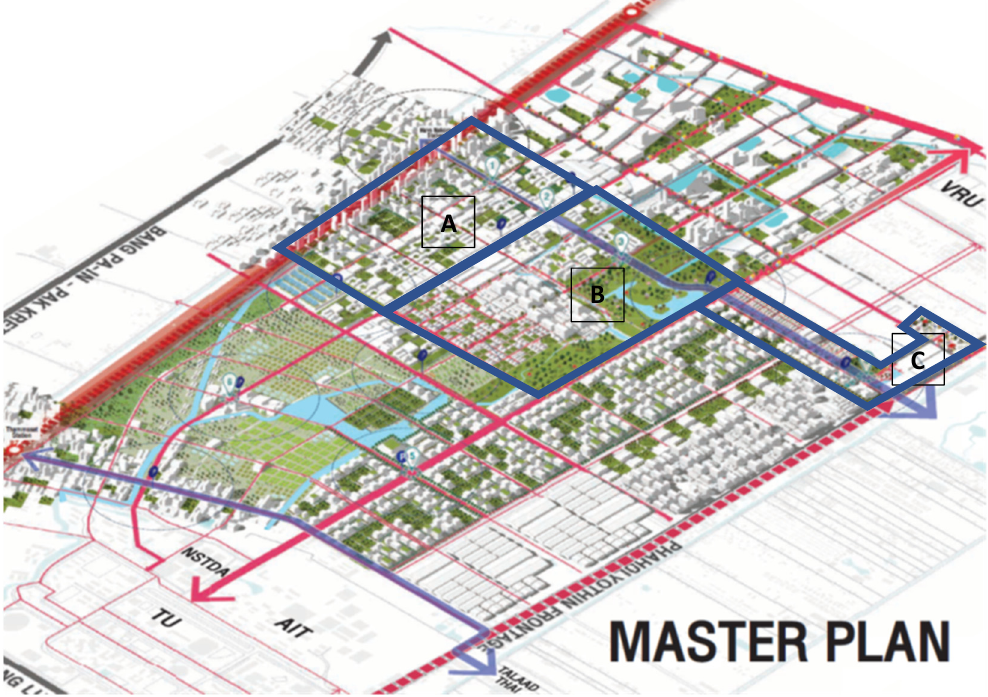
Figure 7. Master-plan overview of Smart City development within the VRU/Nava Nakorn/Thammasat University corridor. Planning zones A, B, and C are outlined with blue lines and are shown in more detail in Figure